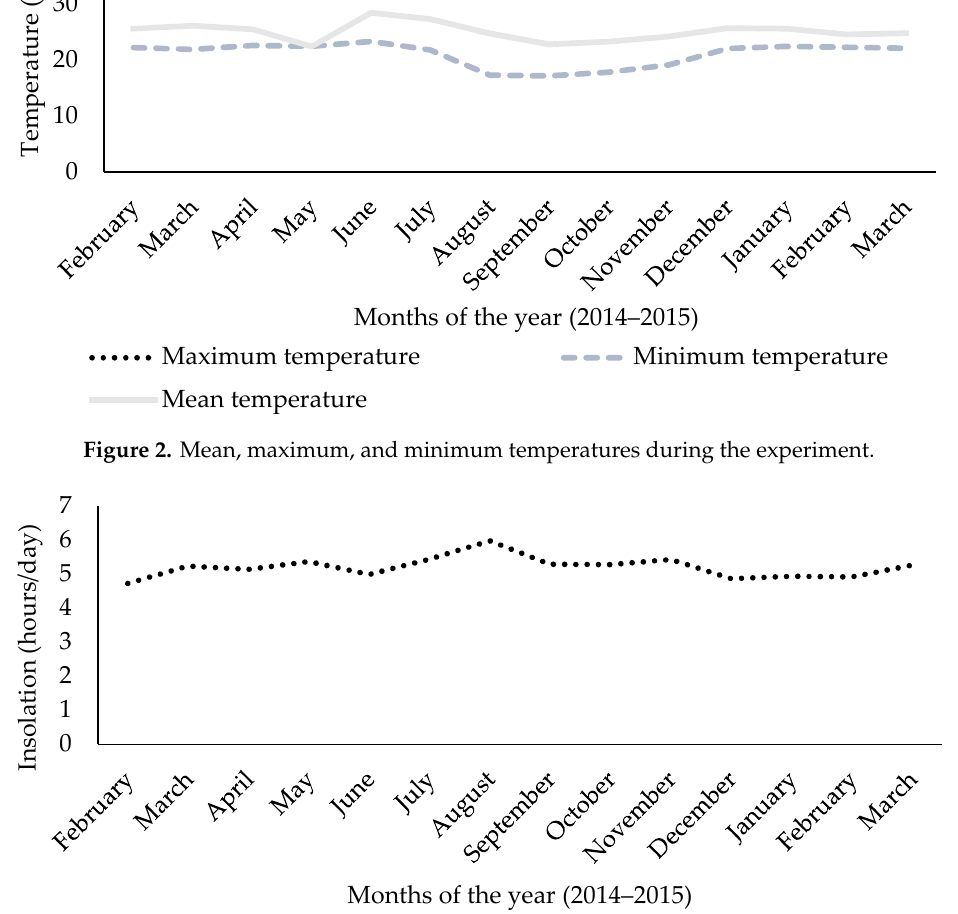
Figure 3. Insolation (hours/day) during the experiment.